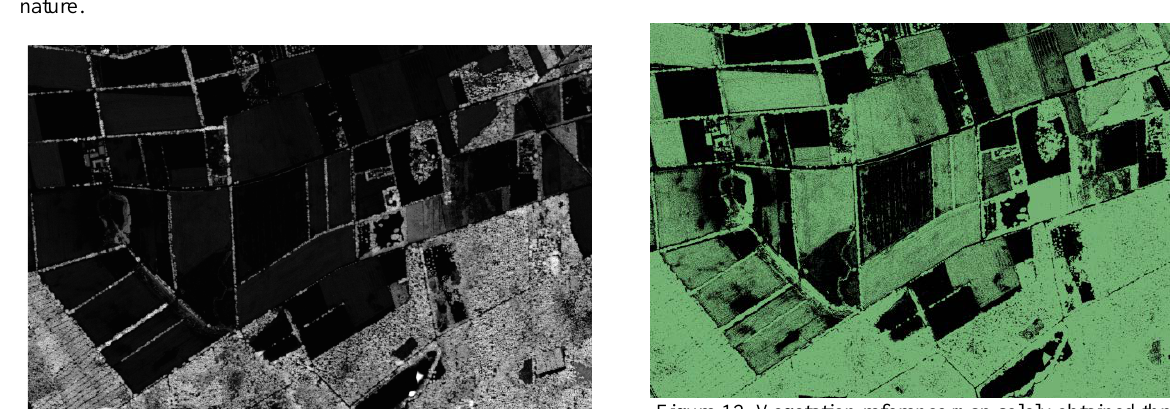
Figure 11. Vegetation map created solely based on unmixing of the spectral data sets without additional information from the DSM. All green pixels represent vegetation.